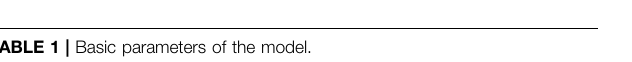
TABLE 1 | Basic parameters of the model.